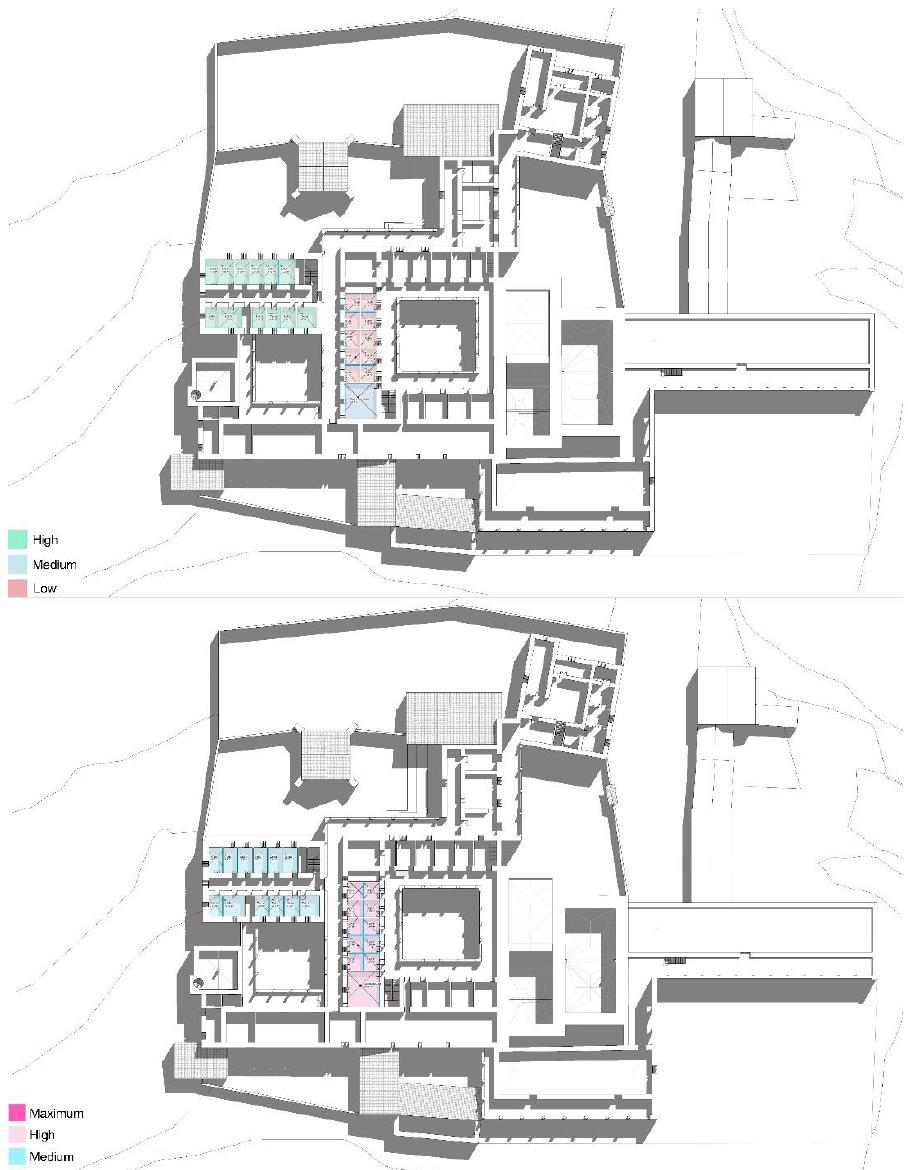
Figure 12. Levels of habitability and patrimonial protection after the study, 2021.